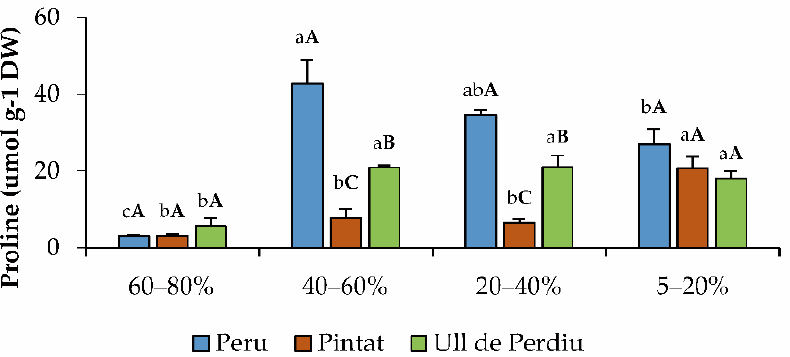
Figure 5. Leaf content of proline in the three Phaseolus lunatus cultivars. Lowercase letters indicate significant differences within each cultivar and uppercase letters (in bold) between cultivars, but within treatments, according to Tukey’s test (α = 0.05). p values according to one-way ANOVA.